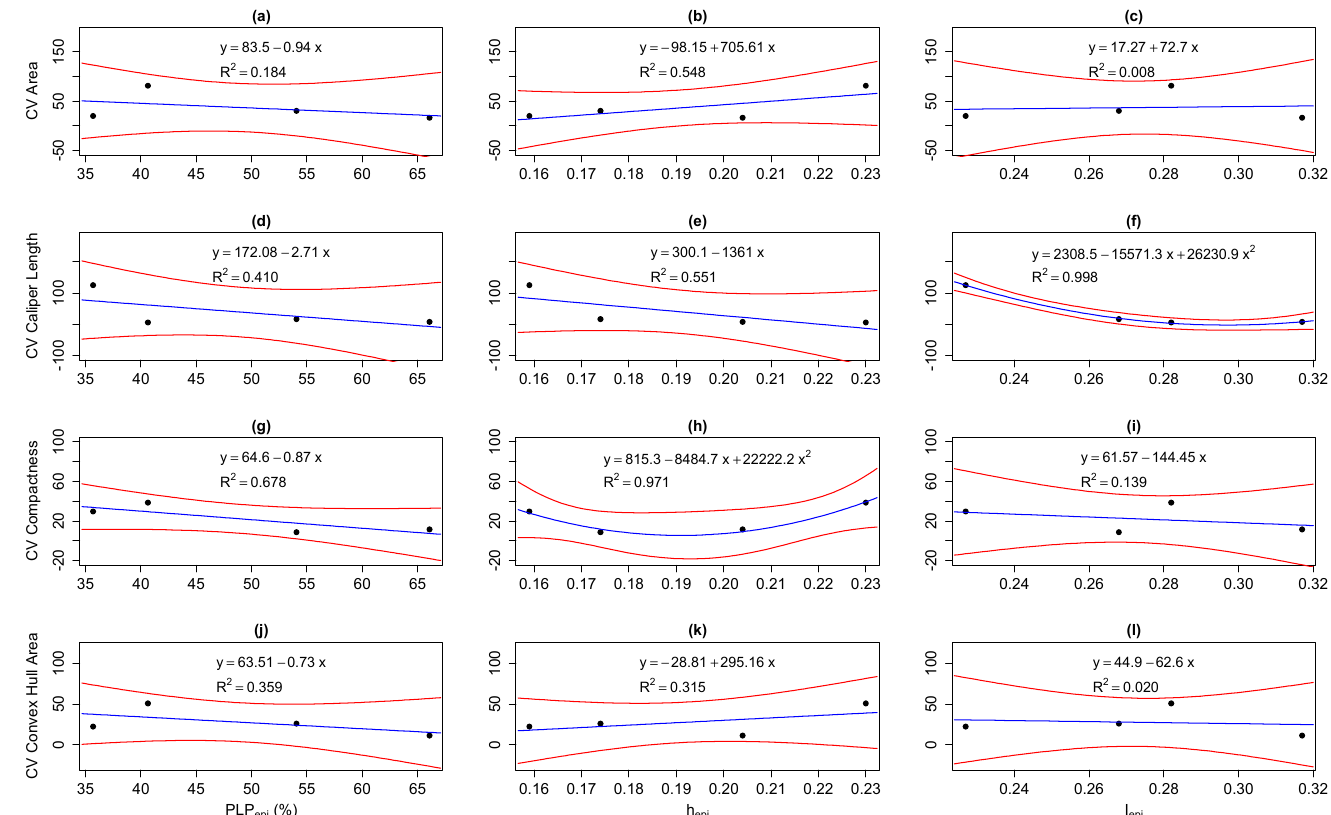
Figure 4. Relationships between intra-population genetic diversity and phenotypic variation of pre-defined sweet cherry populations ( n = 4). The dots represent the observed mean values per population, the blue lines represent the model fit, and the red lines correspond to the lower and upper limits of the 90% confidence intervals. The fitted model and the corresponding R 2 are also displayed ( a – l ).